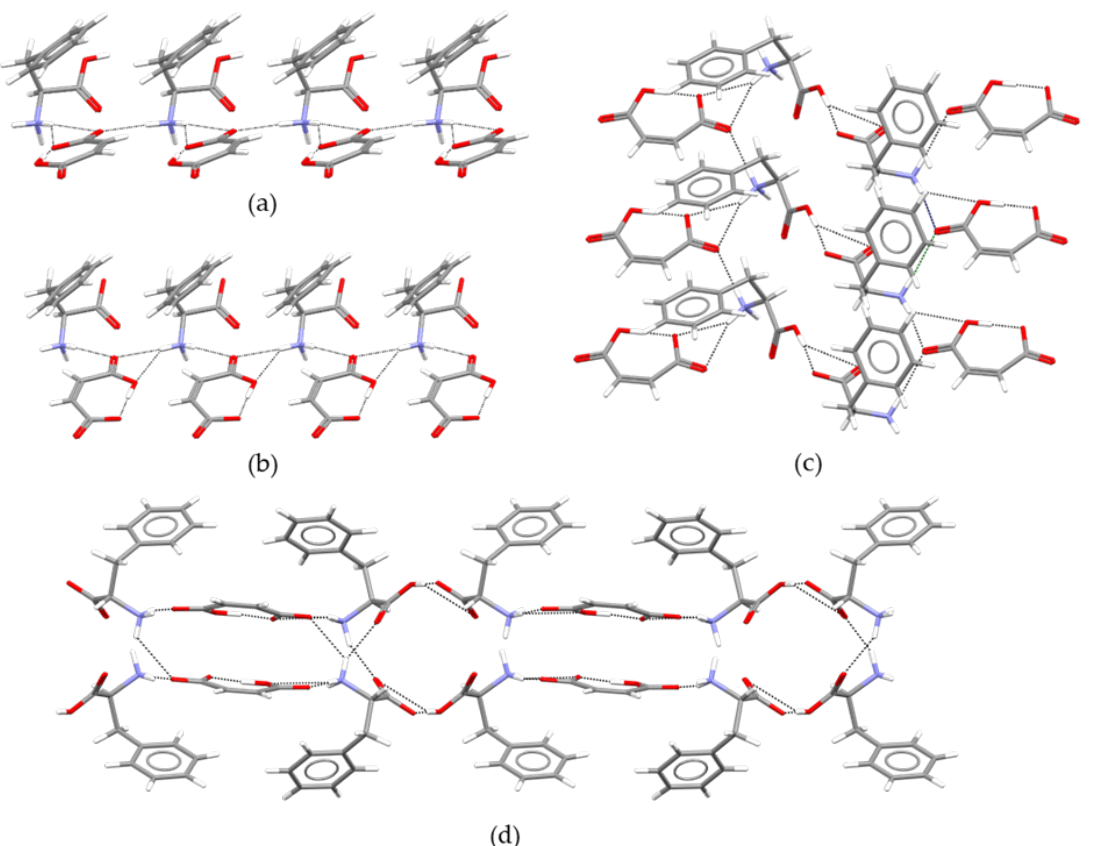
( 4 ) chain consisting of cationic and anionic units, HPhe + − MA − − HPhe + ; Figure 2. Packing motifs of MA:Phe 2 : ( a ) C 1 2 Figure 2. Packing motifs of MA:Phe 2 : ( a ) 1 (4) C chain consisting of cationic and anionic units, HPhe + −MA − −HPhe + ; ( b ) 2 ( 4 ) chain composed of zwitterionic and anionic units, Phe ± − MA − − Phe ± ; ( c ) 2D packing motif in the bc plane; ( b ) C 1 2 1 (4) C chain composed of zwitterionic and anionic units, Phe ± −MA − − Phe ± ; ( c ) 2D packing motif in the bc plane; ( d ) 3D ( d ) 3D crystal packing projected in the ac 2 crystal packing projected in the ac plane.